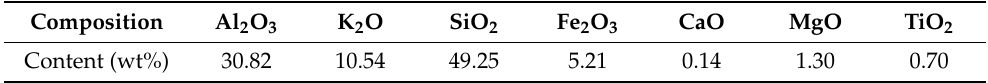
Table 1. The chemical multi-elemental analysis of